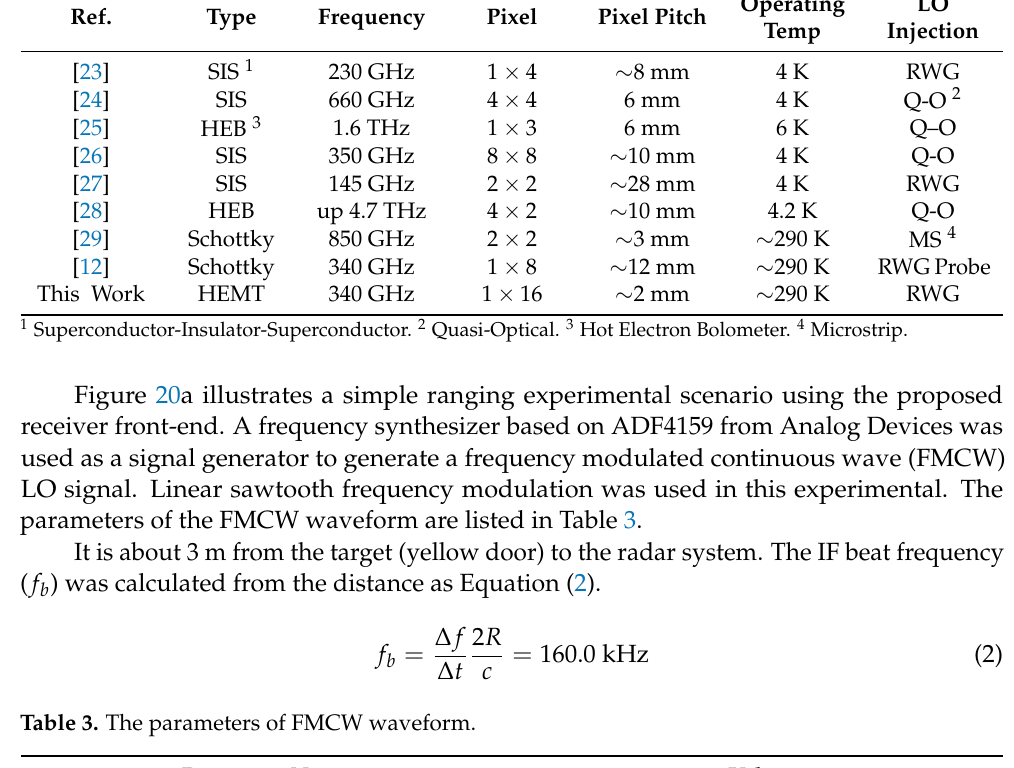
Table 2. Comparison among the presented terahertz heterodyne array receiver front-end. Ref.